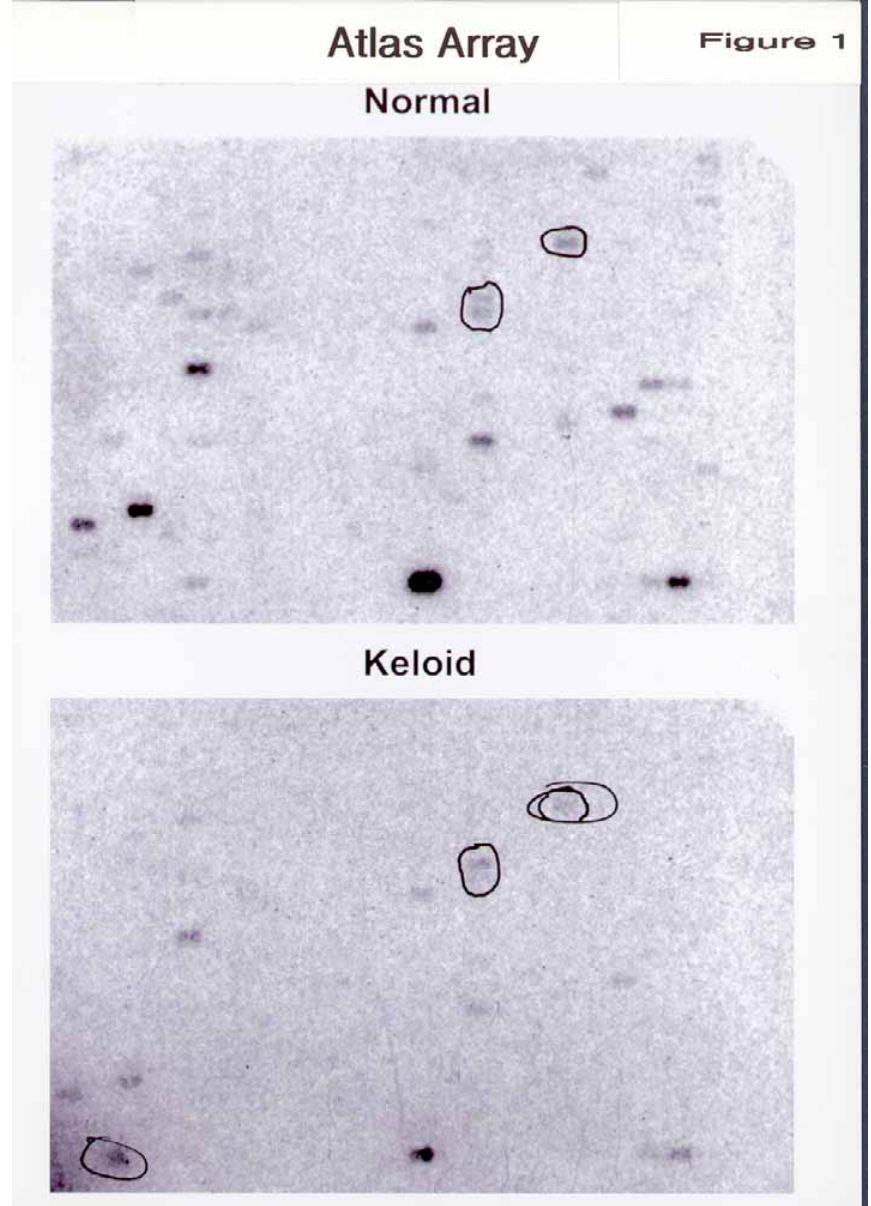
Figure 1. Differential gene expression in human keloid and normal dermal fibroblasts using Atlas Human Array. Poly A+ RNA was isolated from normal (upper panel) and keloid dermal fibroblasts (lower